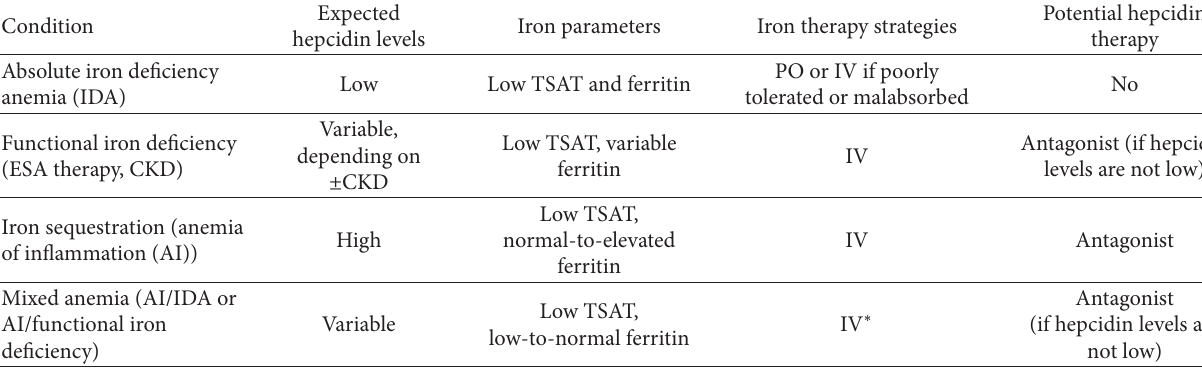
Table 1: Potential role of iron therapy in management of anemia